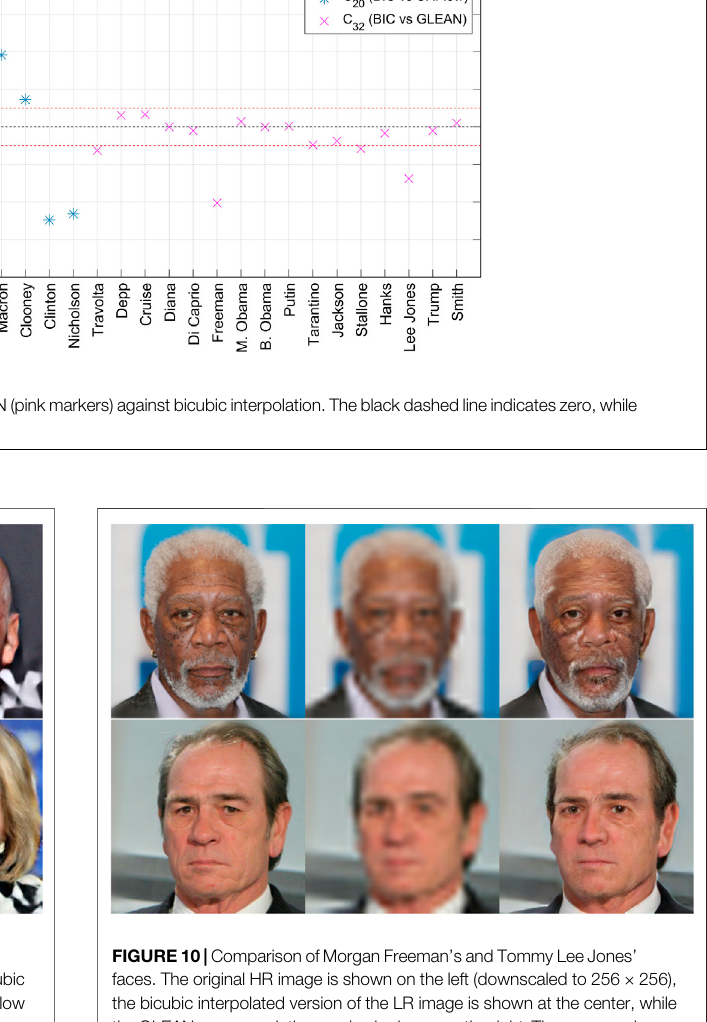
Frontiers in Signal Processing |